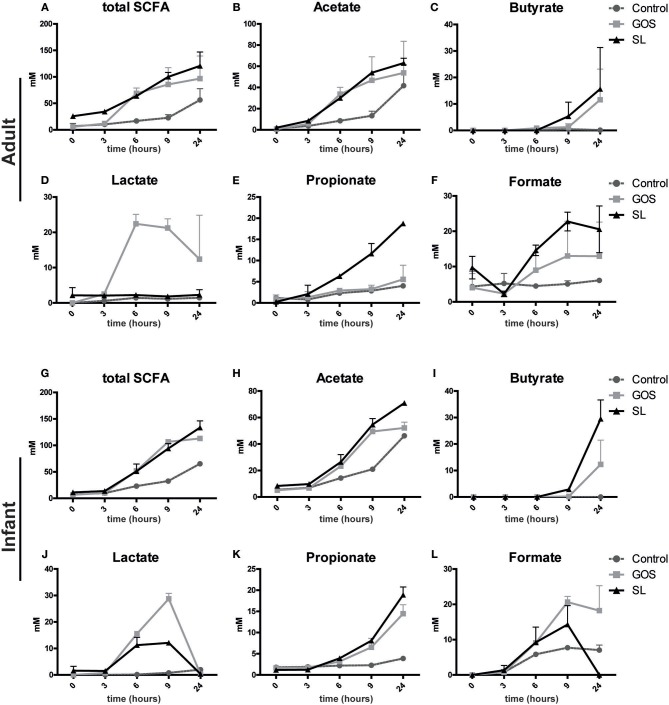
SL and GOS differentially stimulate SCFA production. Batch cultures of (A–F) adults and (G–L) infants pooled fecal samples were inoculated with SL or GOS. Fecal samples were collected at the start (0 h) and after a culture time of 3, 6, 9, and 24 h. SCFA levels were measured in the fecal samples by HPLC. SCFA levels of two independent batch cultures were represented as mean ± SEM.